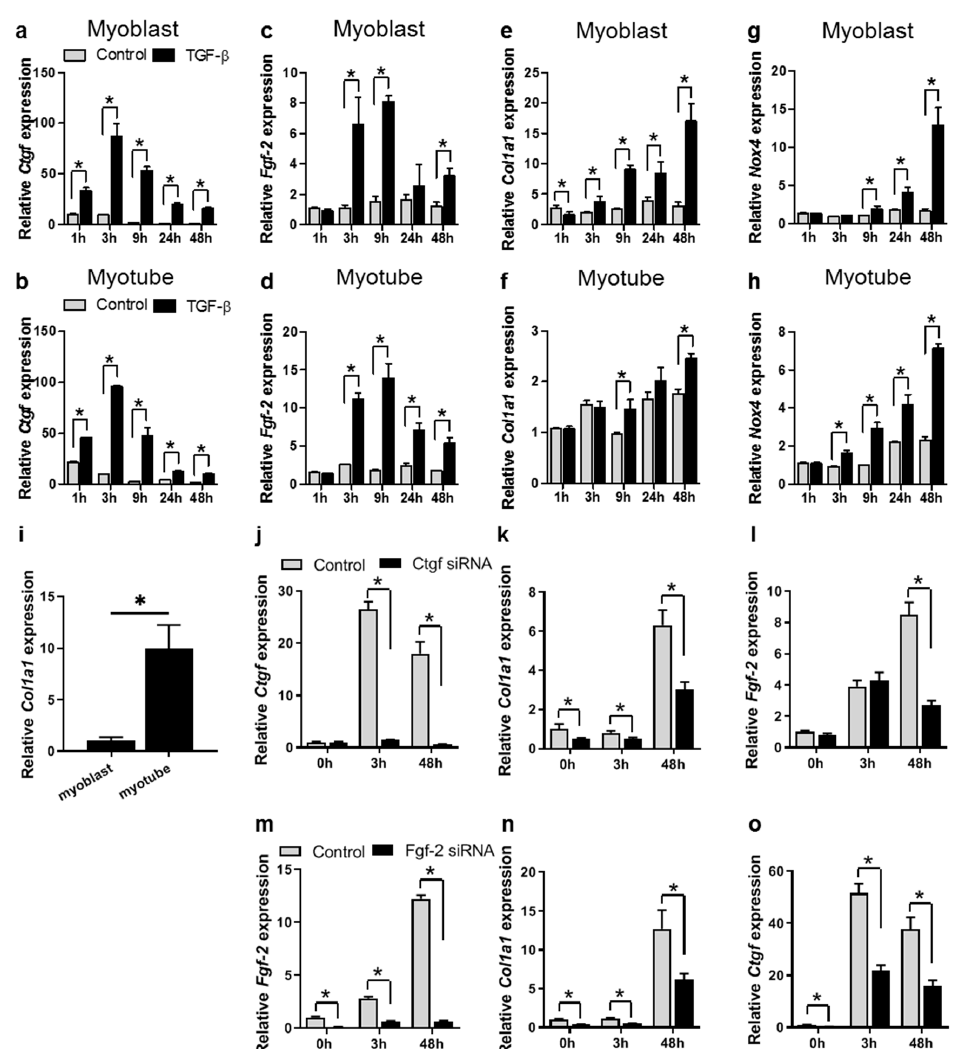
Figure 4. TGF- β a ff ects fibrotic gene expression levels in myoblasts and myotubes in a time-dependent matter. ( a – h ) mRNA expression levels of ( a ) Ctgf in myoblasts, ( b ) Ctgf in myotubes, ( c ) Fgf-2 in myoblasts, ( d ) Fgf-2 in myotubes, ( e ) Col1a1 in myoblasts, ( f ) Col1a1 in myotubes, ( g ) Nox4 in myoblasts, ( h ) Nox4 in myotubes. ( a–d ) In myoblasts and myotubes, expression levels of Ctgf and Fgf-2 were acutely induced by TGF- β . ( e–h ) Col1a1 and Nox4 expression levels were gradually induced by TGF- β . Gapdh served as housekeeping gene; data were normalized to values of control cells at 0 h; * indicates significant di ff erence at p < 0.05; n = 3 experiments per condition ( a – h ). ( i ) Col1a1 mRNA expression levels in myotubes were approximately 10-fold higher compared to those in myoblasts. Gapdh served as housekeeping gene; data were normalized to expression values in myoblasts. * p indicates significant di ff erence at < 0.05; n = 6 experiments per condition. ( j ) At all time points after siRNA treatment, Ctgf expression was knocked down by > 90%. ( k ) Col1a1 expression was reduced in the presence of siRNA targeting Ctgf . ( l ) After 3 h of TGF- β treatment, Fgf-2 expression increased independent of Ctgf . After 48 h of TGF- β treatment, in the presence of siRNA targeting Ctgf, Fgf-2 expression was significantly reduced. m At all time points after siRNA treatment, Fgf-2 expression was knocked down by > 81%. Both Col1a1 ( n ) and Ctgf ( o ) expression levels were significantly reduced in the presence of siRNA targeting Fgf-2 compared to those of control siRNA condition. Gapdh served as housekeeping gene; data were normalized to values of control cells at 0 h; * indicates significant di ff erence at p < 0.05; n = 6 experiments per condition ( j–o